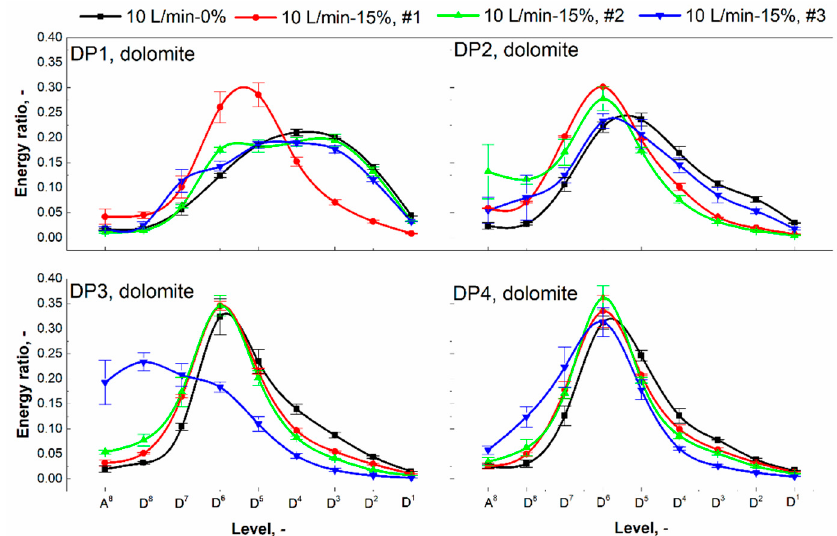
Figure 7. Effects of the gas extraction location on the energy distribution profiles of multi-scale resolved differential pressure signals from DP1~DP4. The other operational conditions were: T = 550 ◦ C, P = 0.1 MPa, H ini = 1.28 m, U = 0.09 m/s, extraction rate = 1.5 L/min, calcined dolomite.